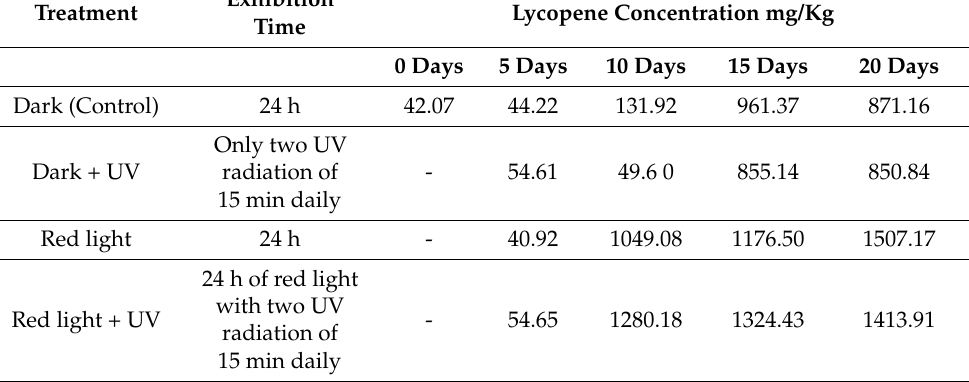
Table 2. Lycopene content, per kg tomato irradiated by red light + UV [34]. Treatment